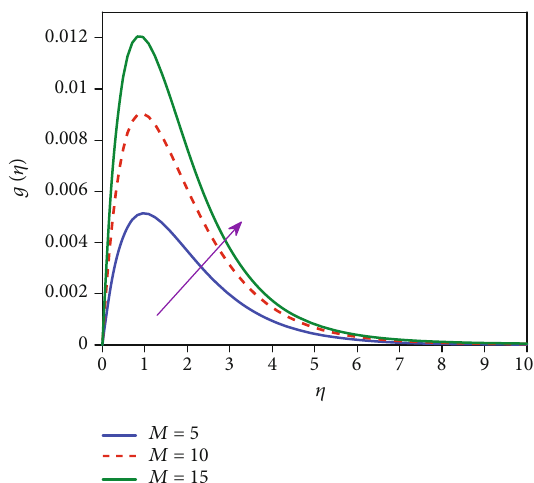
Figure 7: E ff ect of M on the secondary velocity g ð η Þ .